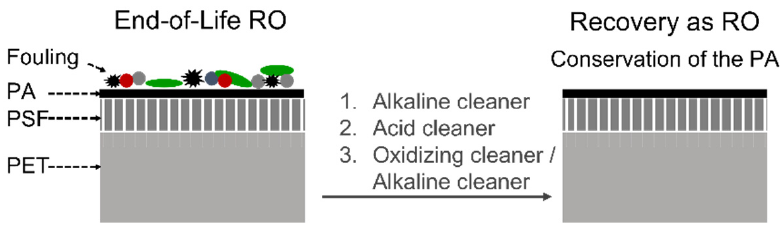
Figure 6. Schematic illustration of EoL RO membrane recovery for direct reuse as RO. PA, polyamide; PSF, polysulfone; PET, polyester.